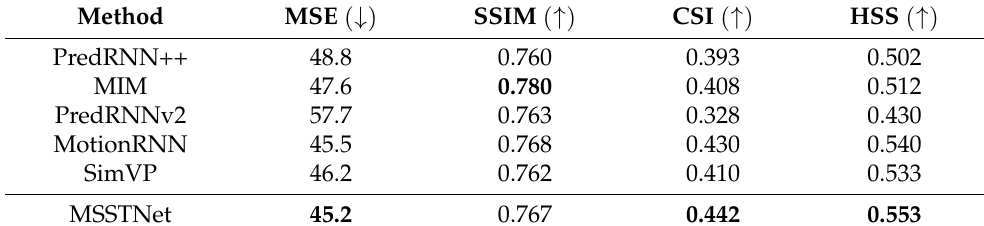
Table 7. Performance comparison results of the models in Radar Echo.